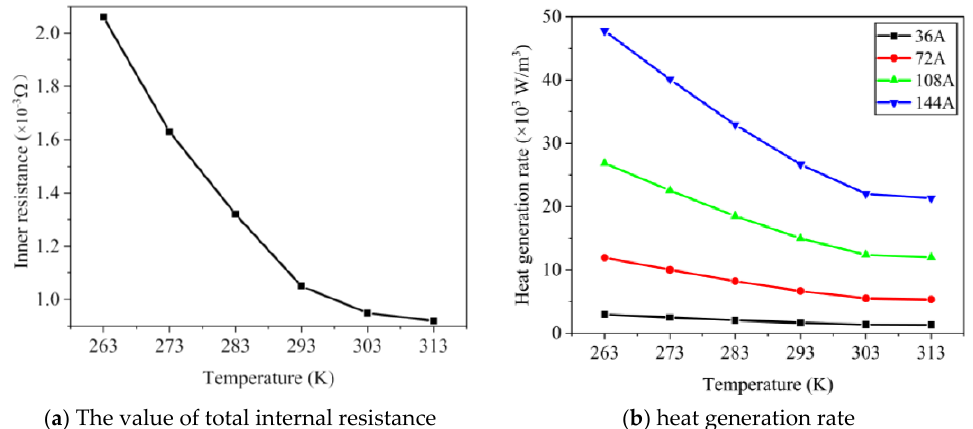
Figure 1. The value of total internal resistance and heat generation rate.